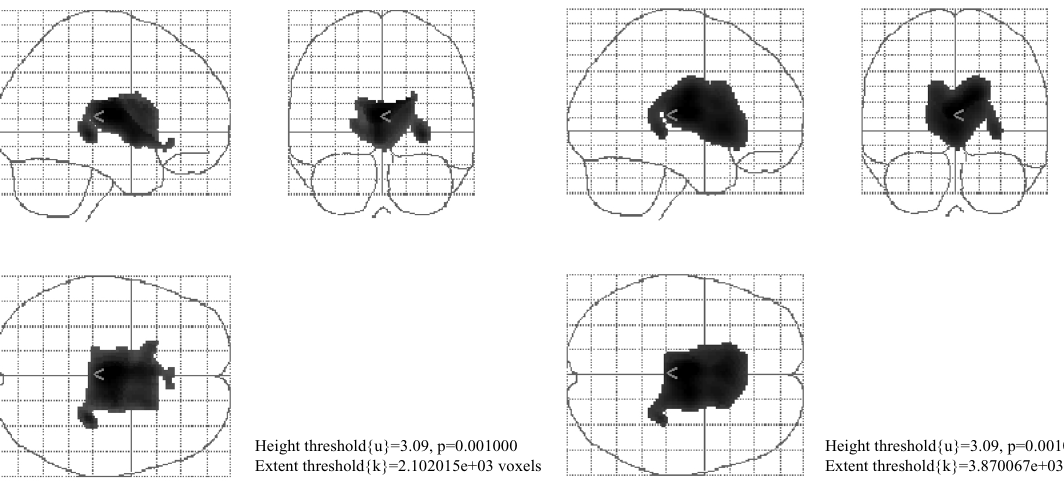
Fig. 1. SPM results comparing the patient group with control subjects; Fig. 1(a)(left): whole brain normalisation, Fig. 1(b)(right): cerebellar normalisation. The figures illustrate the orthogonal maximum intensity projections of the thresholded statistical parametric map. The map is thresholded at an individual voxel value of 3 . 09 ( p = 0 . 001 ) and clusters of voxels having a probability of chance occurrence of < 0 . 001 , when corrected for multiple comparisons, are displayed.